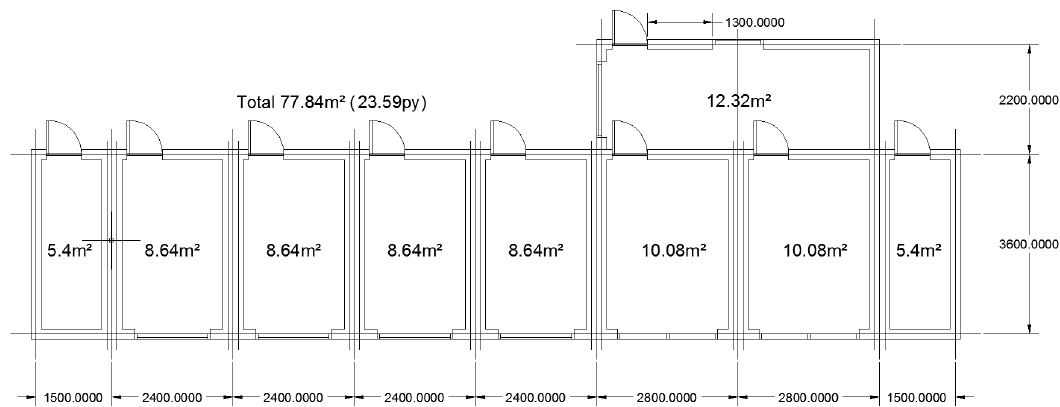
Figure 3. Floor plan of full scale mock-up test facility.